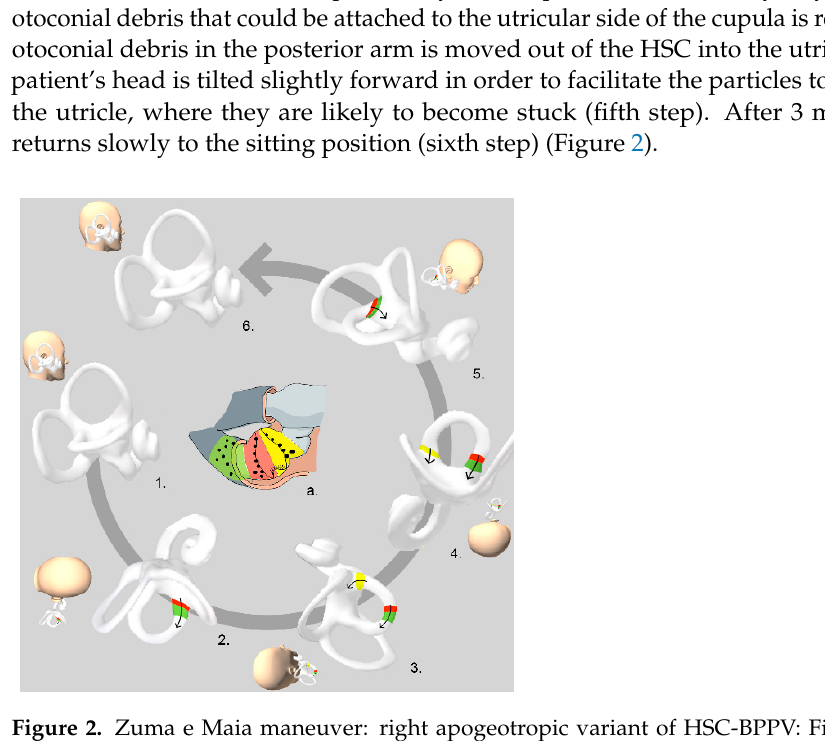
Figure 1. Appiani maneuver: right apogeotropic variant of HSC-BPPV. Image a: detail of horizontal canal cupulla. Red area: otoconia attached to the cupula facing the canal (C-CUP). Green area: free-floating otoconia in the anterior arm (anterior arm canalolithiasis).